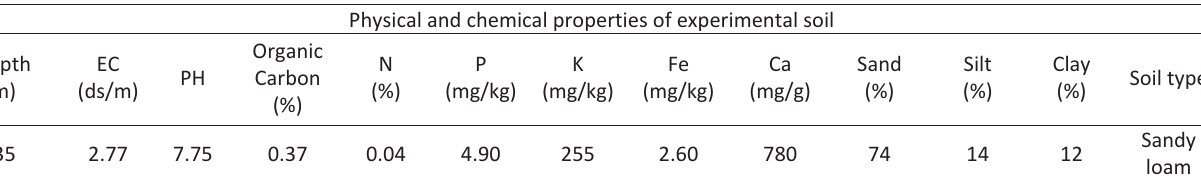
Table 1 ­ Some physical and chemical properties of experimental soil and averages of maximum and minimum temperatures and rain­ fall during the work in 2016 Physical and chemical properties of experimental